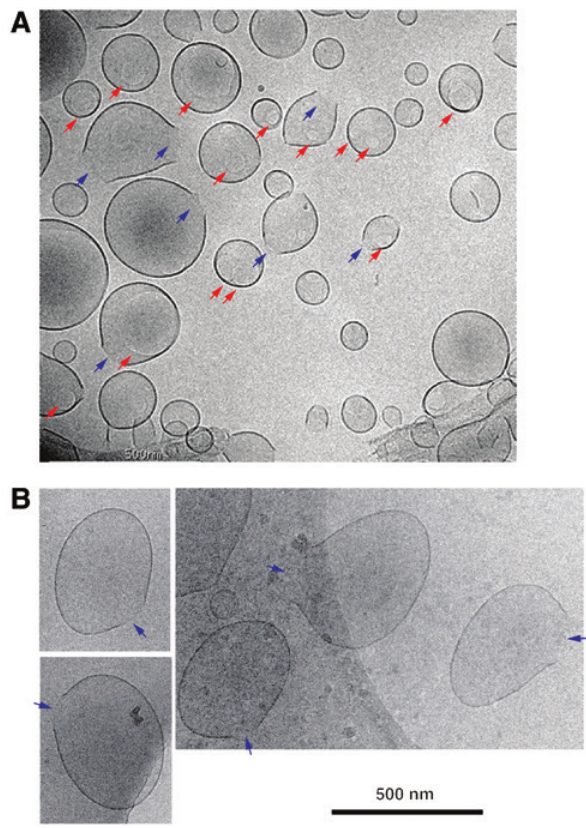
Figure 2: Cryo-EM detects visible pores in liposomes and OMVs following Bax activation. (A) Liposomes were incubated with recombinant Bax and cBid (cleaved Bid; an active form cleaved at the caspase-8 site [22]) for 1 h and plunge-frozen with a Vitrobot and inspected in a Tecnai F20 (FEI; Hillsboro, OR, USA) electron microscope equipped with a field emission gun at 120 keV. The images were recorded with a CCD camera. Most liposomes exhibit visible pores with variable sizes (blue arrows denote side view pores with frayed membrane edges; red arrows, face view pores). By tilt images, they are confirmed to be pores, not overlapping vesicles or osmotic effects [24]. Often multiple pores are seen in one vesicle. No pores are seen in the absence of activated Bax [24]. (B) OMVs were also incubated with Bax and cBid and frozen manually using a plunger. The grids were inspected in a Tecnai G2 (Sphera; FEI) scope with LaB filament as electron source at 200 keV, and the images 6 were recorded by a CCD camera. The ice needed to be thick to accommodate OMVs and they were often present on the carbon area of the grid, which compromised the resolution. We only saw one pore per vesicle (arrows), but pore features such as variable sizes and shapes are very similar to the liposome pores. Refer to Gillies et al. [27] for the control images. (a pore lined completely by protein) or “lipidic” (part of the pore walls consist of lipids) [28]. One example of the former pore is the one formed by pneumolysin, which is visualized by cryo-EM and averaged to high resolution owing to its regular size and shape [29]. Bax pores are too variable in size and not amenable to this